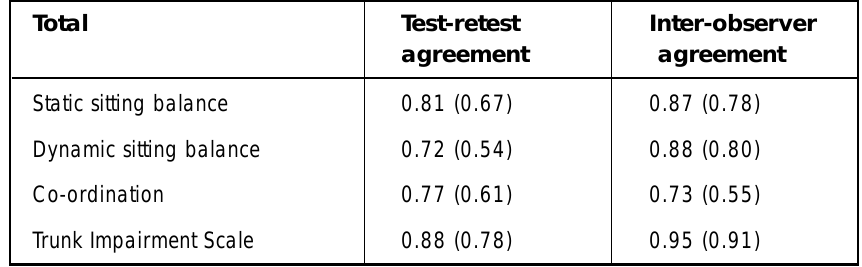
Table 2: ICC values for test-retest and inter-observer